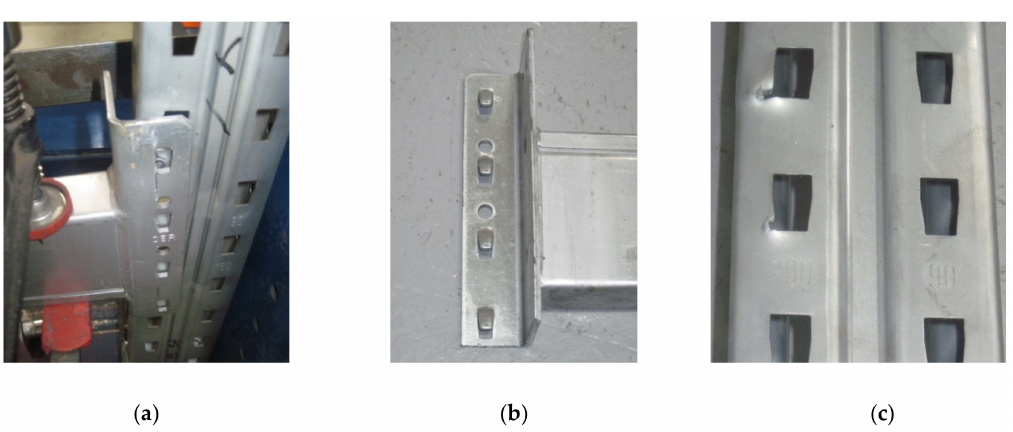
Figure 15. Failure modes of the upright region with a thickness equal to 1.50 mm: ( a,b ) failure mode of the connector and ( c ) failure mode of the upright region.